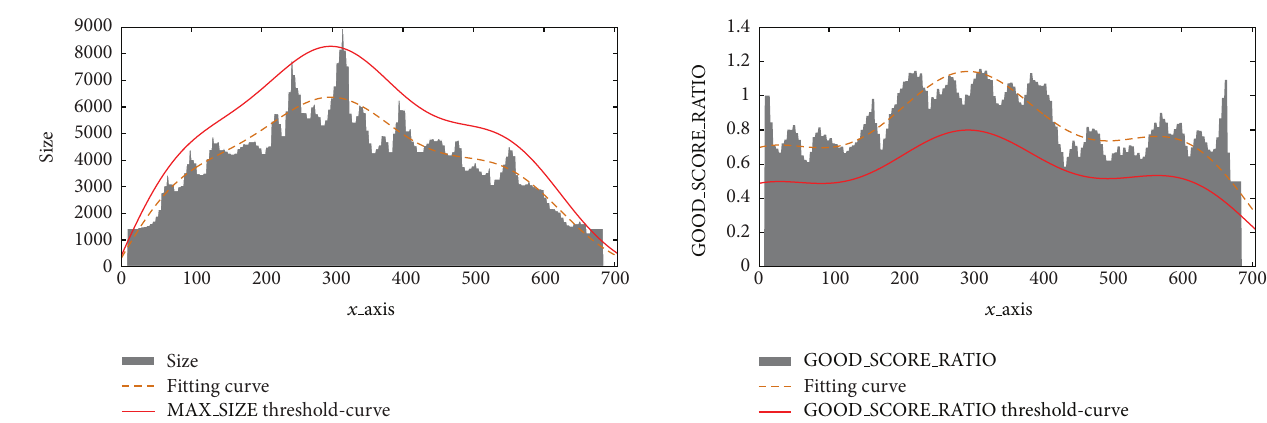
Figure 16: MAX SIZE threshold-curve figure (see (7)).